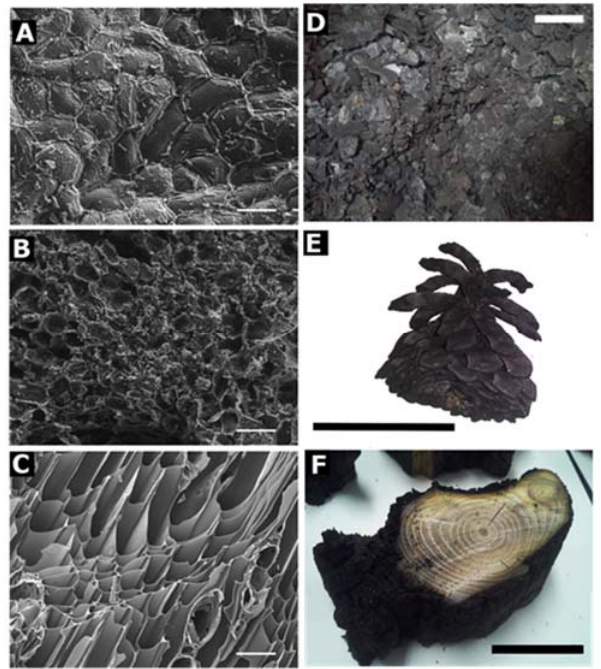
Figure 1. Scanning electron microscopy (SEM) images of charred bark ( A ), charred pine cones ( B ), and charred woody debris ( C ). Scale bars for the SEM images = 50 μ m. Photos to the right of the SEM images ( D–F ) are images of the corresponding charred material. Scale bar for images shown in panels D, E and F = 4